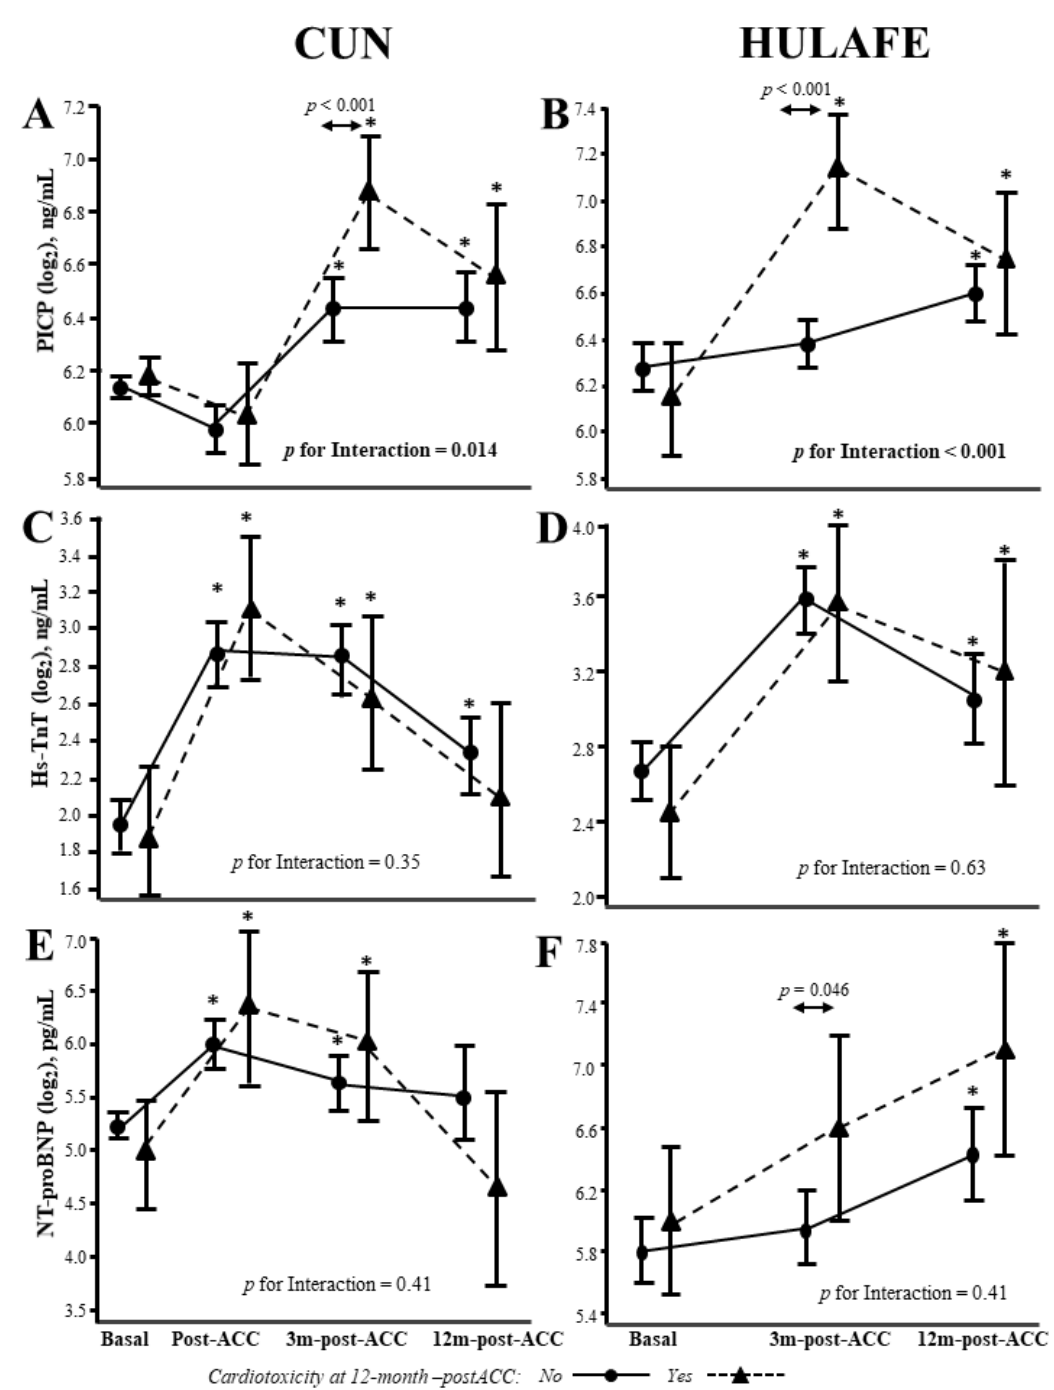
Figure 4. Biomarker levels at different visits in BC patients with presence or absence of cardiotoxicity at 12 months post-ACC. PICP ( A , B ), hs-TnT ( C , D ) and NT-proBNP ( E , F ) circulating levels in patients from the CUN and HULAFE cohorts, respectively, according to the presence (triangle) or absence (circle) of cardiotoxicity at 12 months after completion of ACC (12m-post-ACC). Data are expressed as the estimated marginal means and 95% confidence interval (CI) after linear mixed regression analyses with the biomarker as the dependent variable, and cardiotoxicity (yes/no), visit, their interaction term, and biomarker baseline values as fixed effects. * p < 0.05 vs baseline. BC, breast cancer; ACC, anthracycline-based cancer chemotherapy; NT-proBNP, amino-terminal pro-brain natriuretic peptide; hs-TnT, high-sensitivity troponin T; PICP, procollagen type-I C-terminal propeptide.